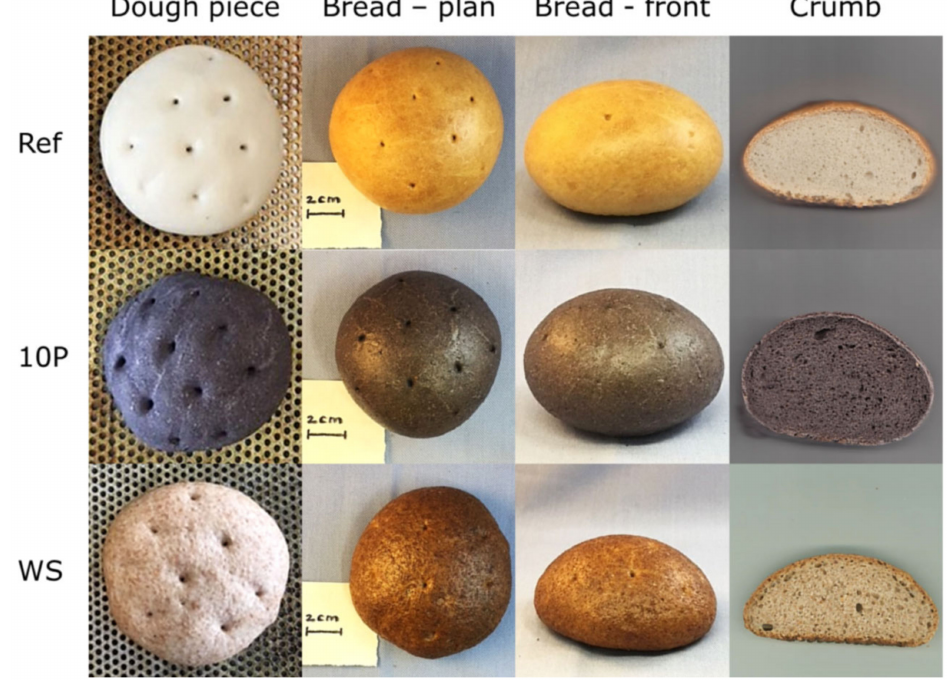
Figure 4. Appearance of dough, bread, and crumb. Ref, reference; 10P, dough / bread based on 90% wheat flour and 10% pomace; WS, wholegrain spelt